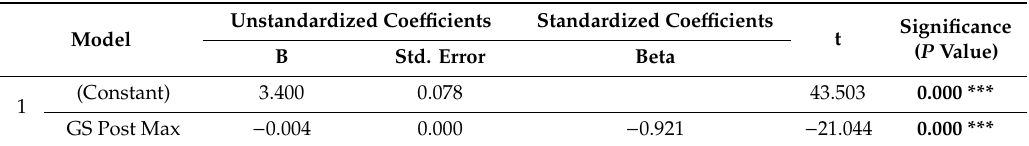
Table 6. Stepwise regression analysis for prediction of osteoporosis presence via GS values at di ff erent jaw